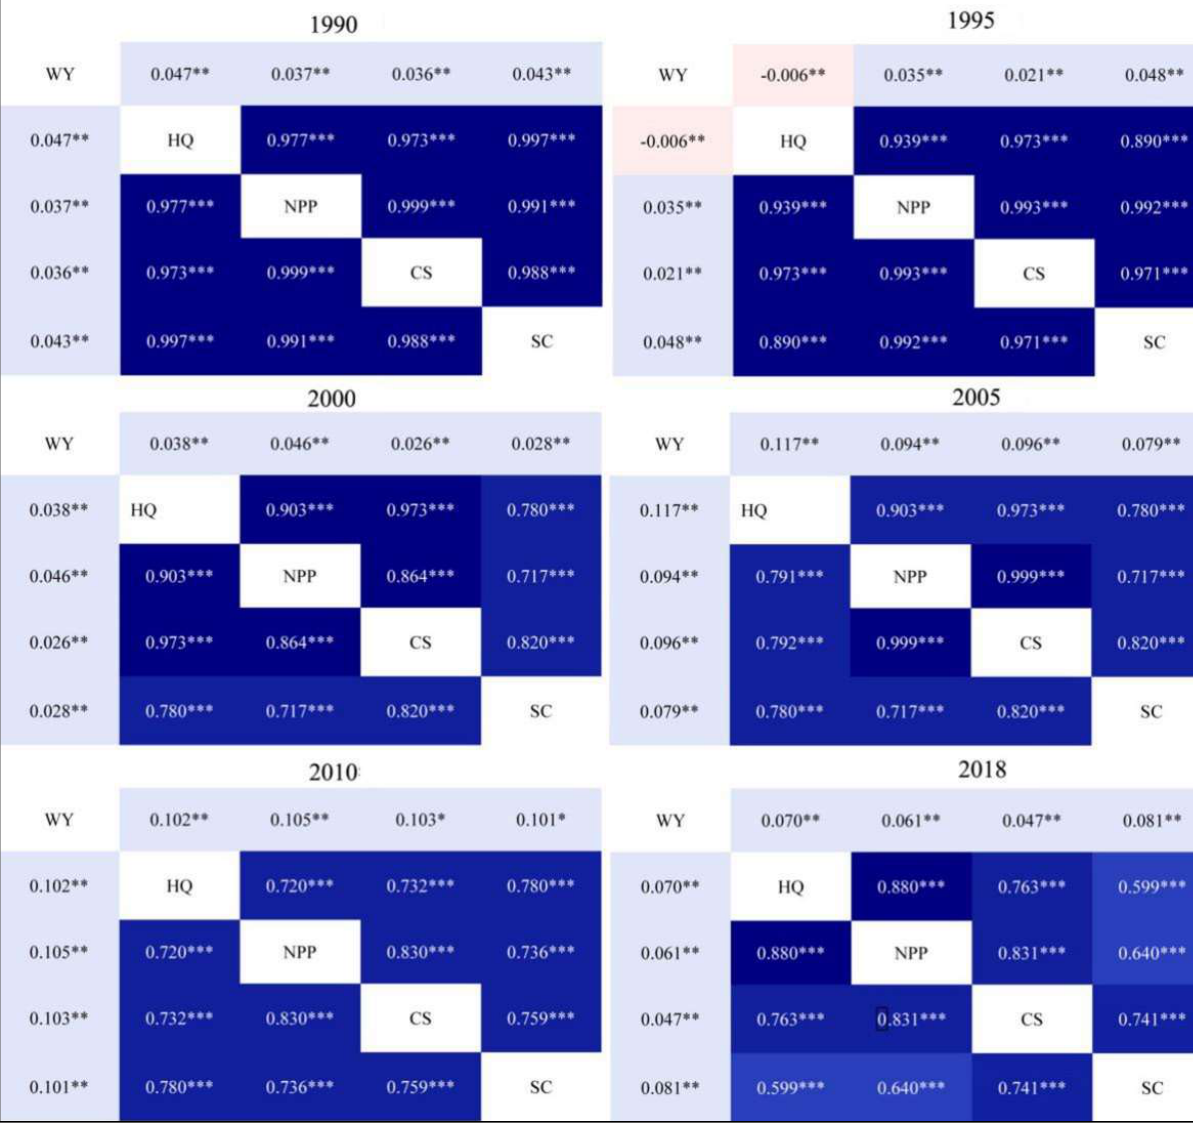
Figure 3. Trade-off and synergy coefficient of five ecosystem services of grassland in the Yellow River basin from 1990 to 2018 (WY: water yield; CS: carbon storage; HQ: habitat quality; SC: soil conservation). Note: *** p < 0.01; ** p < 0.05; * p < 0.1.